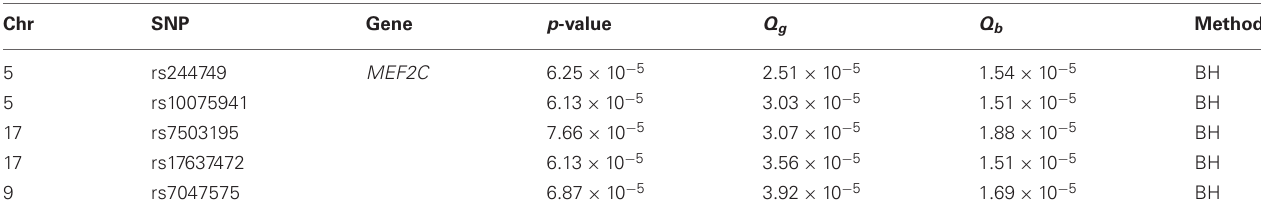
Table 2 | Additional significant SNPs or positive results identified by eQTL weighting methods after accounting for linkage disequilibrium in the GABRIEL